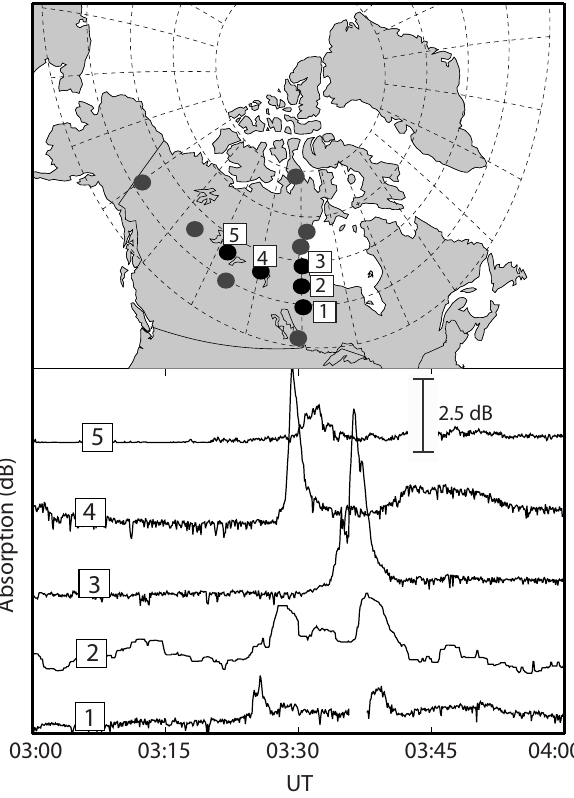
Fig. 6. Riometer recordings from ISL (number 1), GIL (number 2), FCC (number 3, 58.76 ◦ N), RAB (number 4, 58.22 ◦ N) and FSM (number 5, 60.03 ◦ N). First northward and then westward propaga- tion of the absorption event is clearly visible. Gillam data has been filtered and the signal is good for timing purposes.